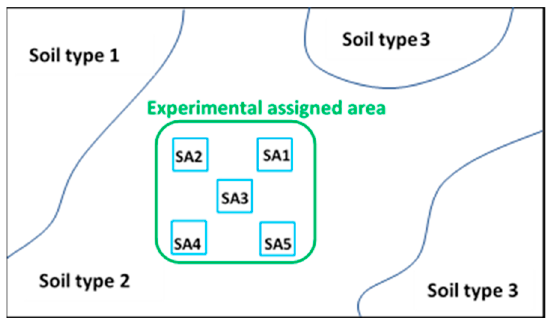
Figure 1. Layout of a commercial experimental site (not to scale). At this site, the experimental as- signed plot is selected in soil type 2. Sampling and monitoring are conducted in five sub-areas (SA1– SA5) over the crop